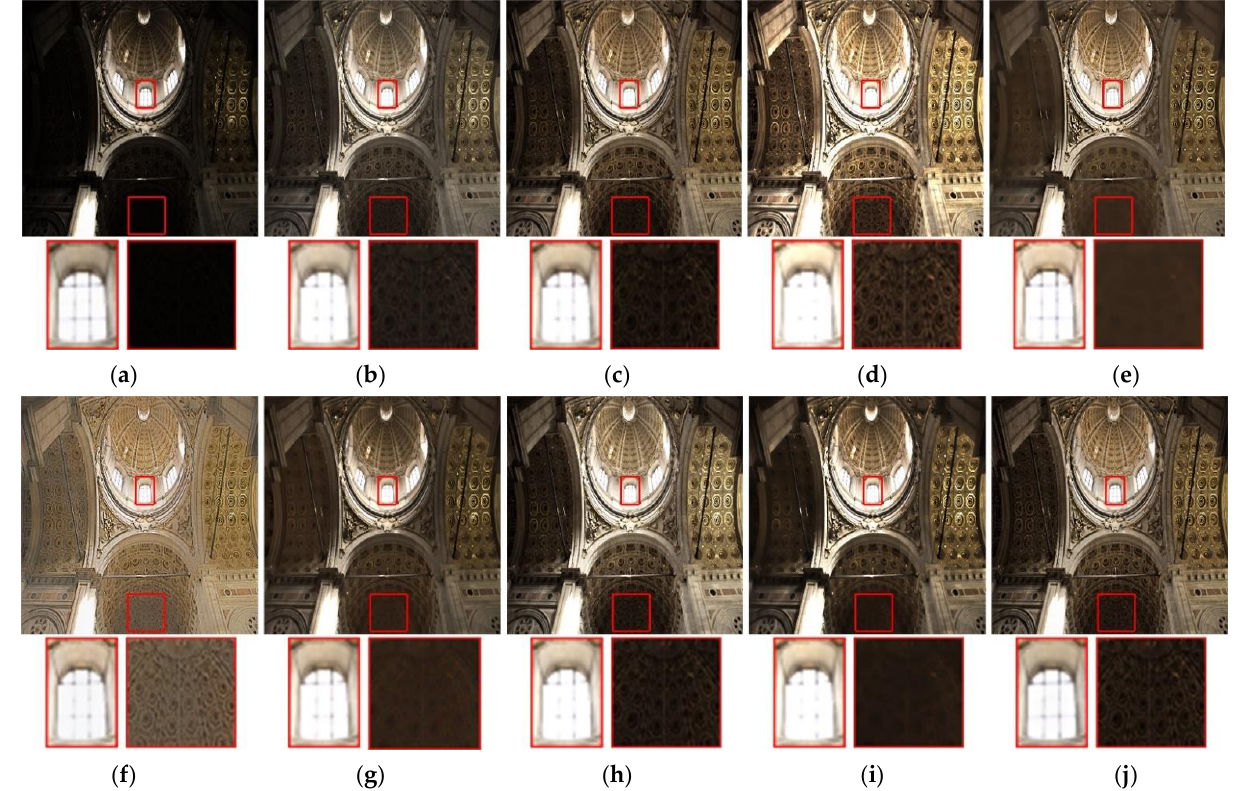
Figure 22. Enhanced results of “Church” image. ( a ) Original image; ( b ) BIMEF; ( c ) MF; ( d ) LIME; ( e ) SR; ( f ) Ret-Net; ( g ) FFM; ( h ) LECARM; ( i ) SDD; ( j )